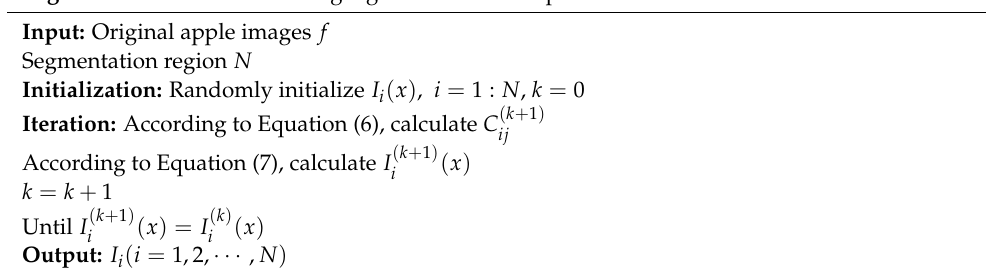
Algorithm 1 K -means clustering algorithm based on pixel block-based